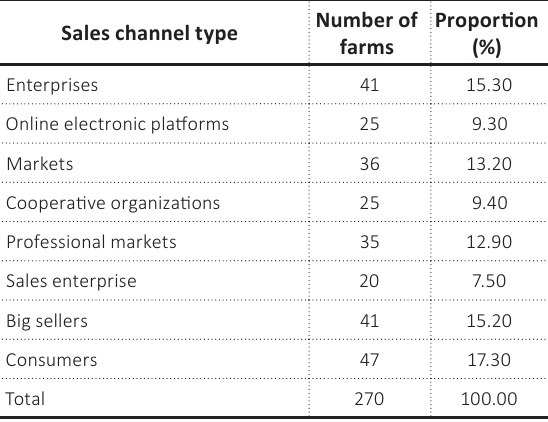
Table 3. Selection of sales channels by family